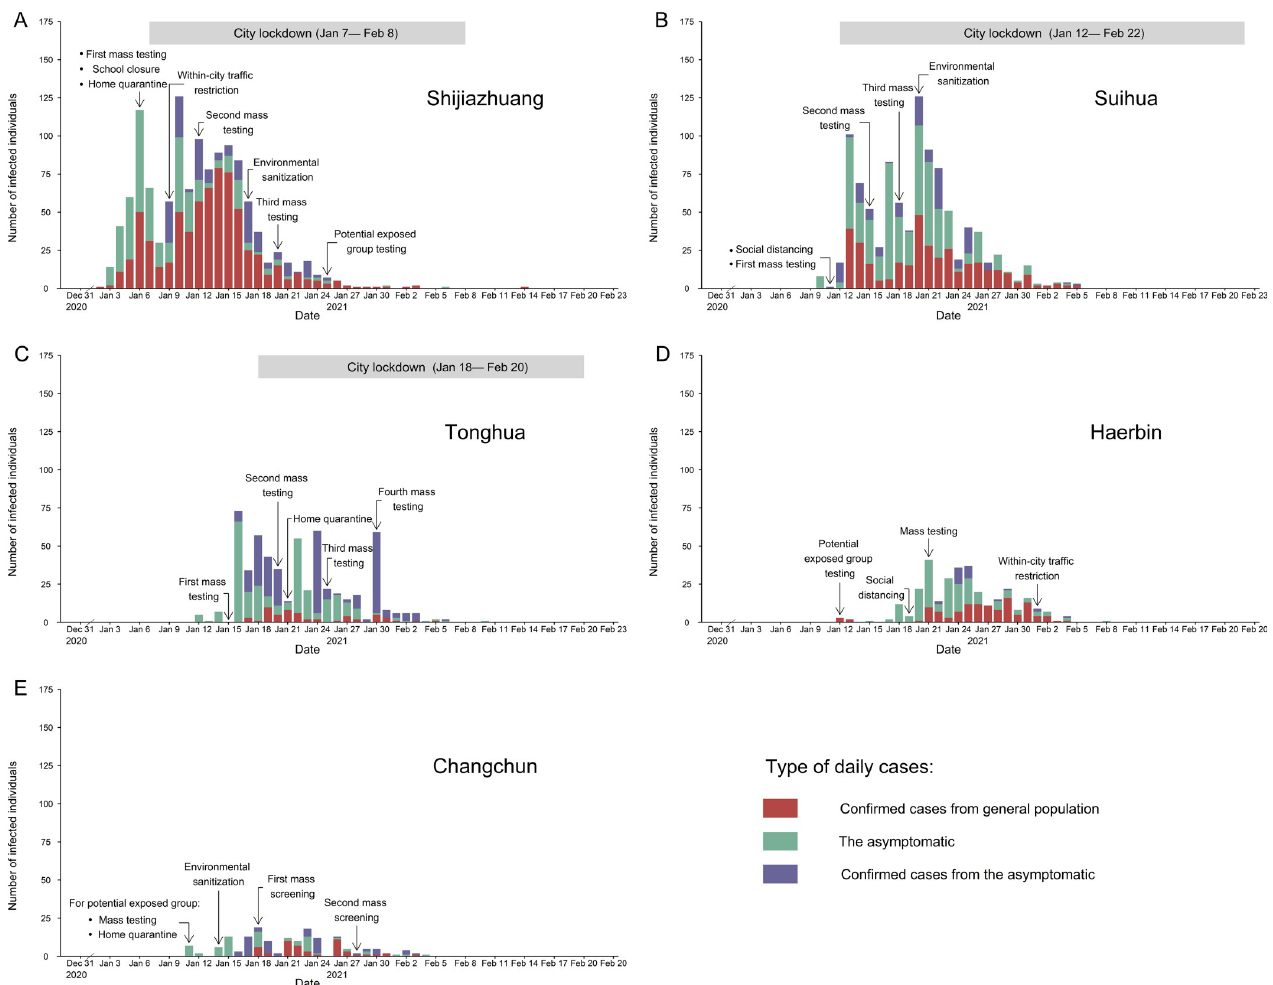
Fig 1. Epidemic curves and non-pharmaceutical interventions implemented in five worst-hit cities in China, Jan-Feb 2021. (A)-(E) The daily number of COVID-19 infections and the timings of specific non-pharmaceutical interventions in Shijiazhuang, Suihua, Tonghua, Haerbin and Changchun cities.